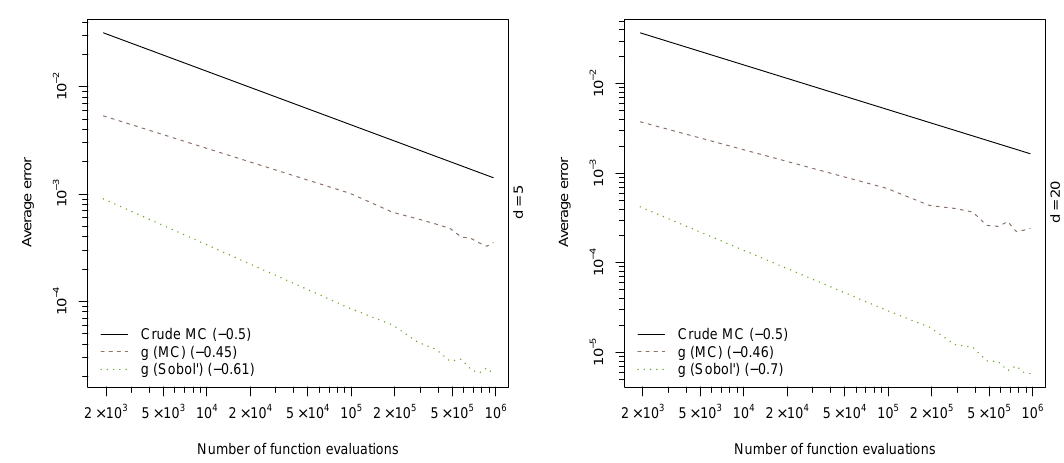
Figure 1. Estimated average errors over 15 replications. In each run and for each sample size, P ( X ≤ b ) ( 0 , P , F ) for a random correlation matrix P and a random upper limit is estimated where X ∼ gNVM W d b . For d = 5 ( left ), X j ∼ t 0.5 + j and for d = 20 ( right ), X j ∼ t 0.75 + 0.25 j for j = 1, . . . , d